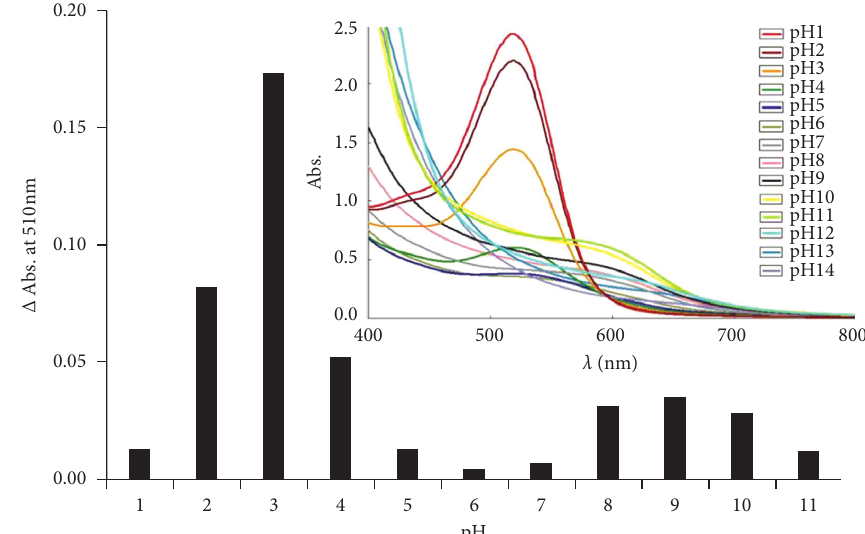
Figure 2: Influence of pH on Δ Abs. of roselle extract. Inset: spectra of roselle extract in various pH.